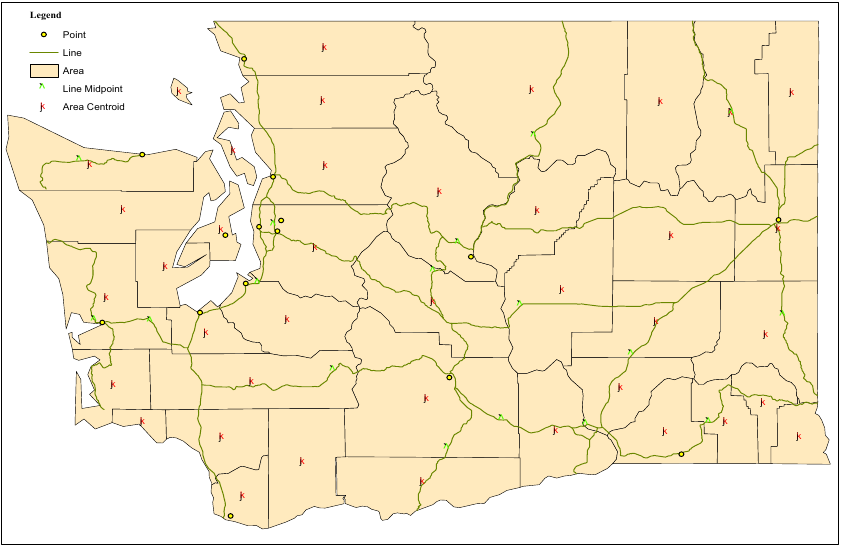
Figure 2. A representation of multiple geographical features, which are polygon, line, and point features. In addition, the centroids of area features and the midpoints of line features are shown.